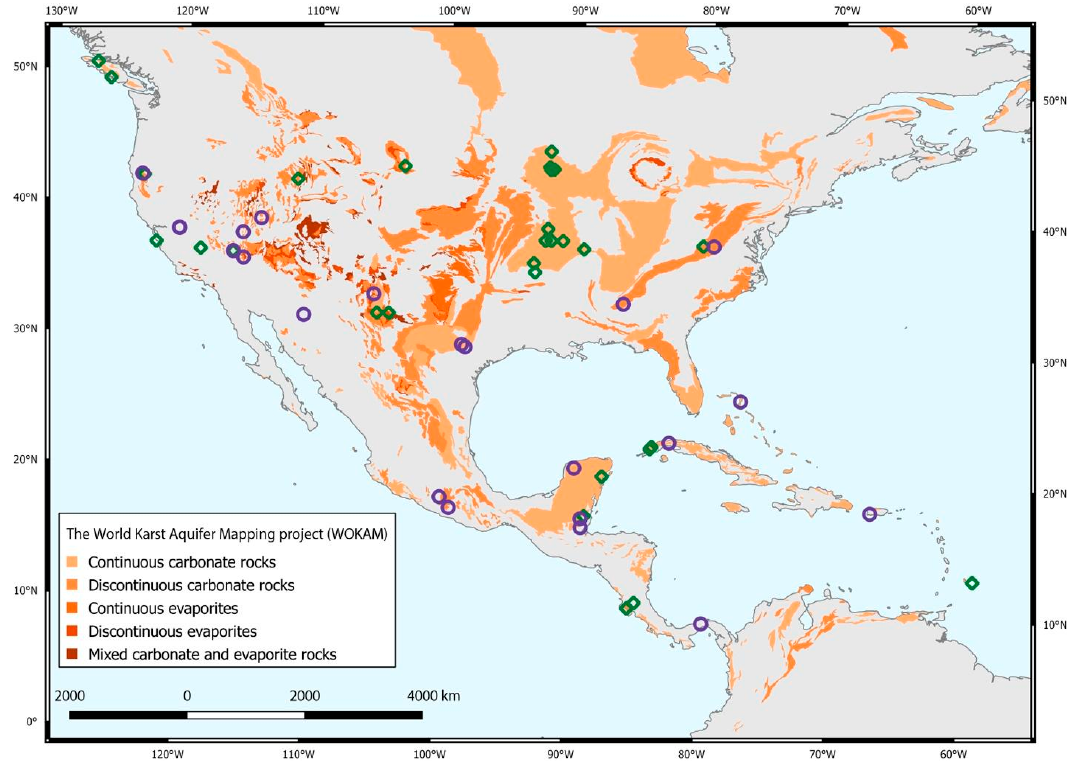
Figure 1. Map showing distribution of carbonate and evaporite rocks in North and Central America provided by the World Karst Aquifer Mapping project (WOKAM [11]). Purple circles indicate speleothem record sites included in SISAL_v1 [1], while green circles indicate speleothem records sites that have been identified, but are not included in SISAL_v1. Specific information about all sites is included in Table 1.